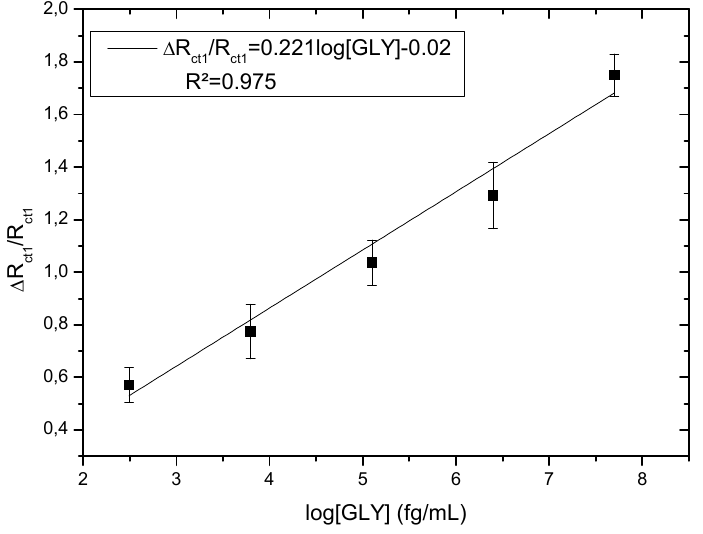
Figure 5. Calibration curves of CS ‐ MIPs/CMA/Au ( Δ R/R = 0.221 log[GLY] − 0.02; R² = 0.975). The detection limit (LOD) of the considered sensor is estimated at 1 fg/mL. LOD was obtained from the equation 3 S/m [52], where S is the residual standard deviation of the linear regression and m is the slope of the regression line. The results showed a low detection limit and high sensitivity. The parameters of the CS ‐ MIPs/CMA/Au sensor are compared to another impedance ‐ meter sensor for the detection of GLY which is based on electropolymerized polypyrrole films, as a conductive layer between the gold microelectrode surface and the molecularly imprinted chitosan film (CS ‐ MIPs/PPy/Au) [27]. The impedance spectrum of the PPy ‐ based sensor is formed by a single semicircle. This result allows concluding that in the present work, the formation of two half ‐ circles in the impedance spectrum is due to the presence of the CMA. The electron transfer rate in the MIPs films of the CS ‐ MIPs/PPy/Au sensor is much higher (55 μ m/s) than that of the CS ‐ MIPs/CMA/Au (5.5 μ m/s) sensor due to the presence of the PPy conductive layer which facilitates the electron transfer. The interest of the covalent attachment of the CS ‐ MIPs film on an underlayer is to eliminate the inhomogeneity of the CS ‐ MIPs film caused by the trapping of the H 2 molecules released during the electrodeposition of the CS film. Due to the insulating property of the CMA film, accumulation of charged species occurred (second semi ‐ circle in the low frequency range), which is not the case using polypyrrole film [27]. Despite this enormous difference, the sensitivities of both sensors (with PPy and with CMA), calculated with the relative resistance variation (R/R), are close (0.30 for CS ‐ MIPs/PPy/Au and 0.221 for CS ‐ MIPs/CMA/Au), the detection limits are the same: 1 fg/mL and their possible recyclability is the same. 4.3. Comparison between MIPs and NIP The response of the NIP sensor was modeled with the model developed. Figure 6 shows the theoretical and experimental evolution of Re (Z) as a function of − Im (Z). A good fit is achieved between the experimental data and the theoretical data with a fairly